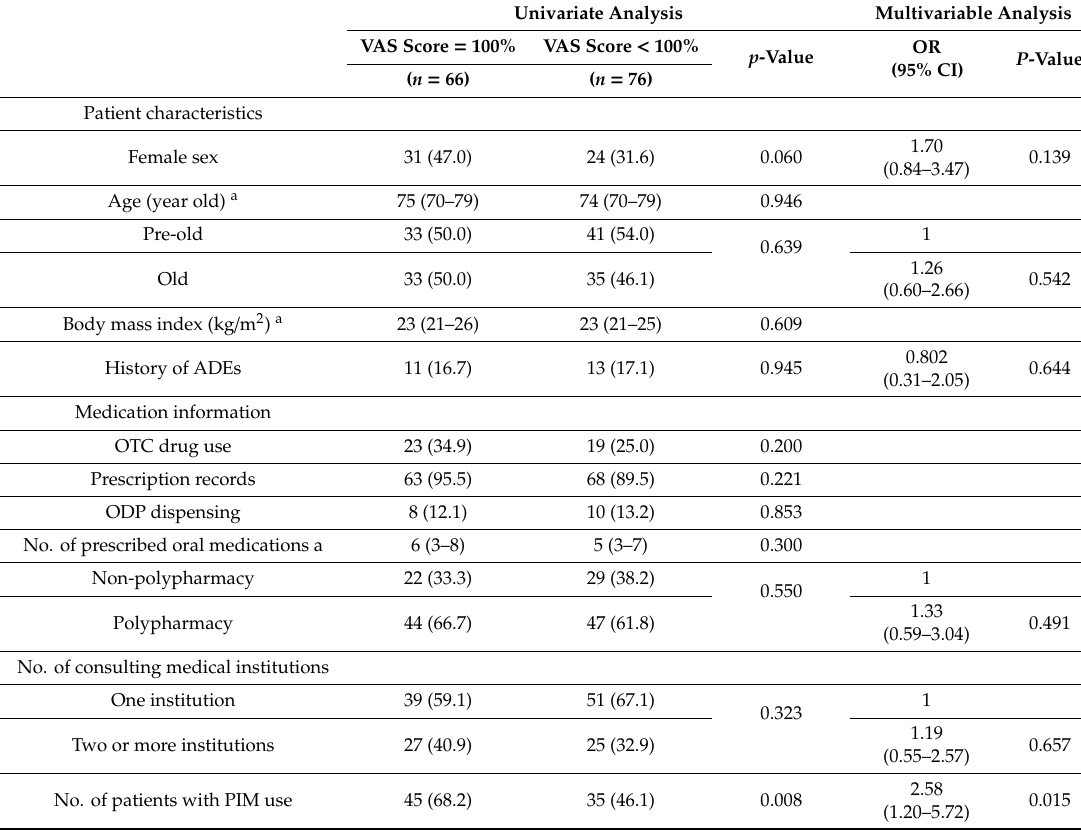
Table 5. Univariate and multivariable analyses results for a VAS score of 100% ( n = 142). Univariate Analysis Multivariable